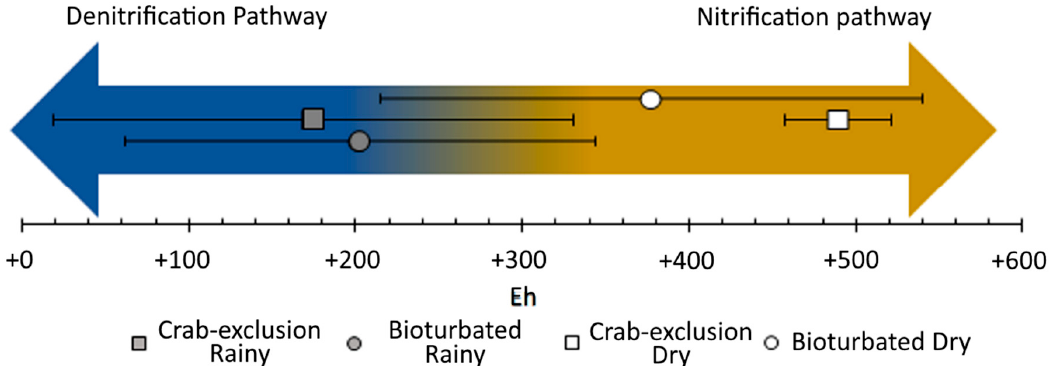
Figure 6. Comparison of measured N 2 O emissions (mean and standard deviation) from the studied mangroves in relation to redox soil conditions across sites and mangroves in relation to redox soil conditions across sites and seasons.